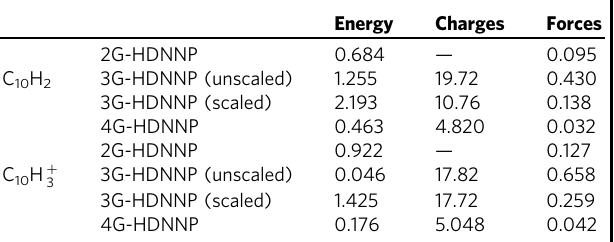
forces are not matched by high energy errors, which instead are Table 1 Energy and charge error obtained for the organic molecules. Energy error (meV/atom) and mean errors of the atomic charges (10 − 3 e) and forces (eV/ Å ) of C 10 H 2 and C 10 H þ with respect to DFT obtained with the different 3 HDNNP generations for the DFT-optimized structures. For the 3G-HDNNP the results for scaled and unscaled charges are given. Energy Charges Forces